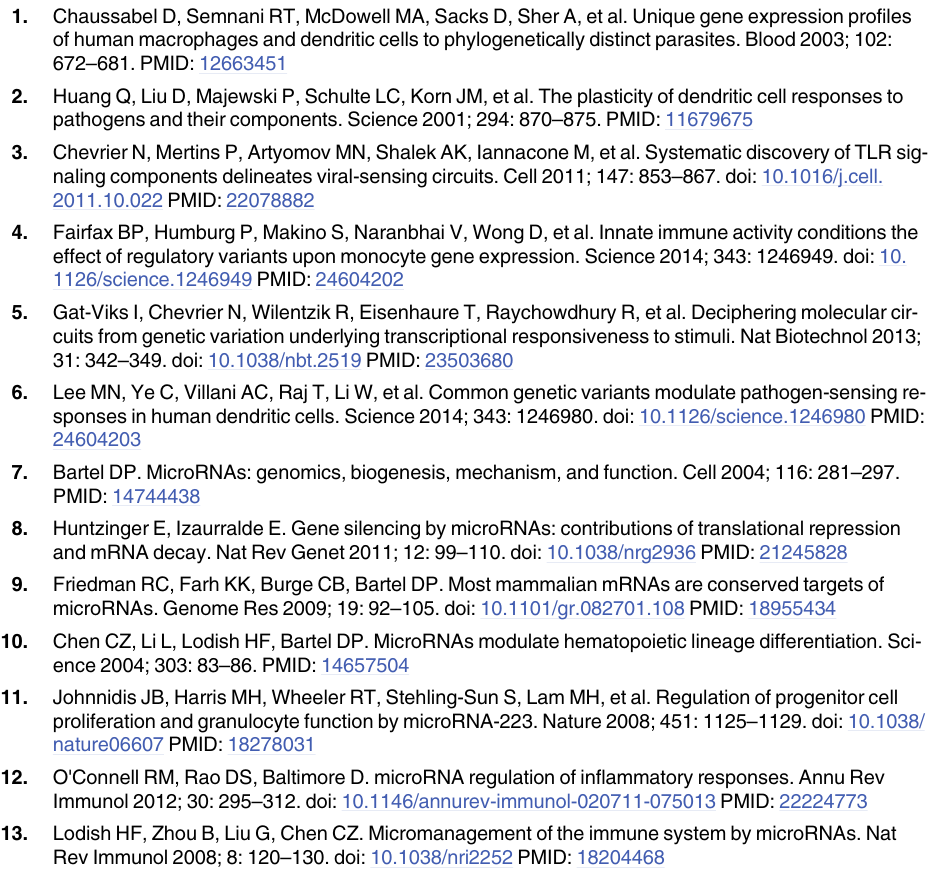
statistics reflecting infection-in- ST